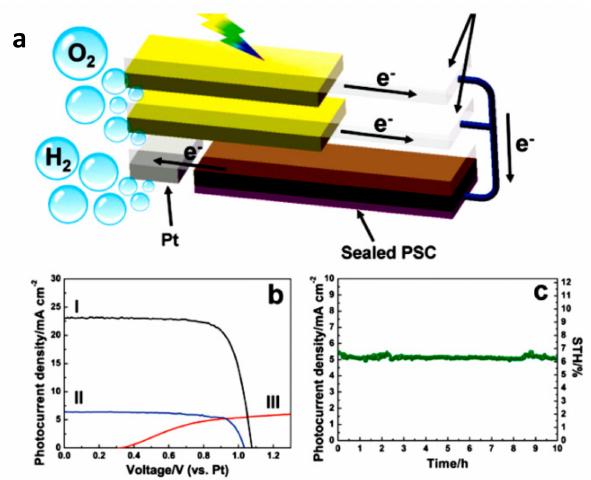
Figure 7. ( a ) The BiVO 4 -FeOOH/NiOOH dual photoanodes coupled with s sealed perovskite solar cell; ( b ) I: J – V curve of perovskite solar cell, II: J – V curve of perovskite solar cell behind the BVO-FeOOH / NiOOH